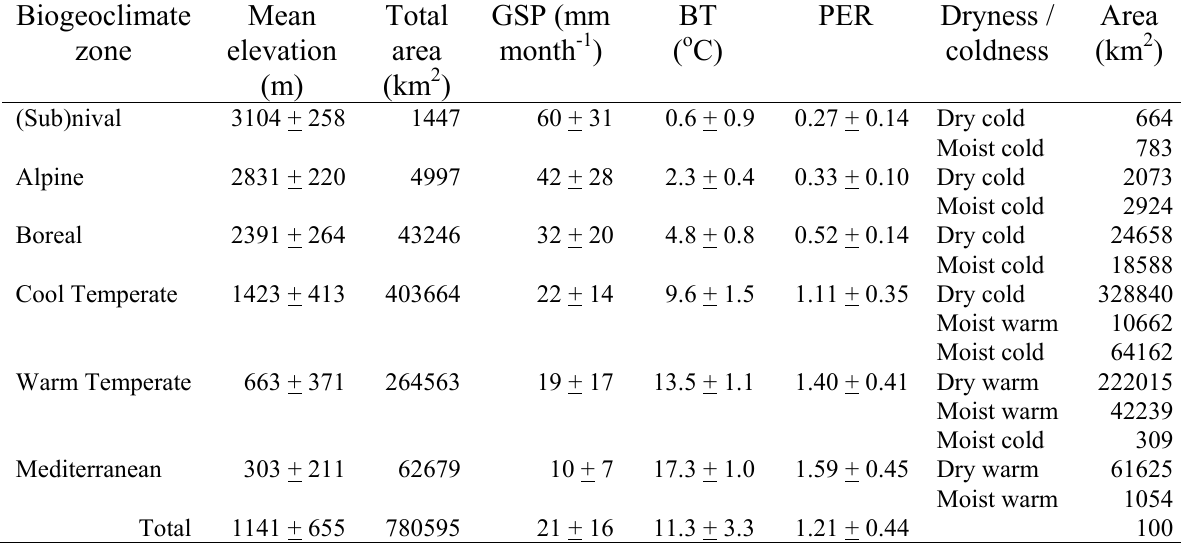
Table 2. Properties (mean + SD) and spatial extent of biogeoclimate zones along aridity and biotemperature gradients across